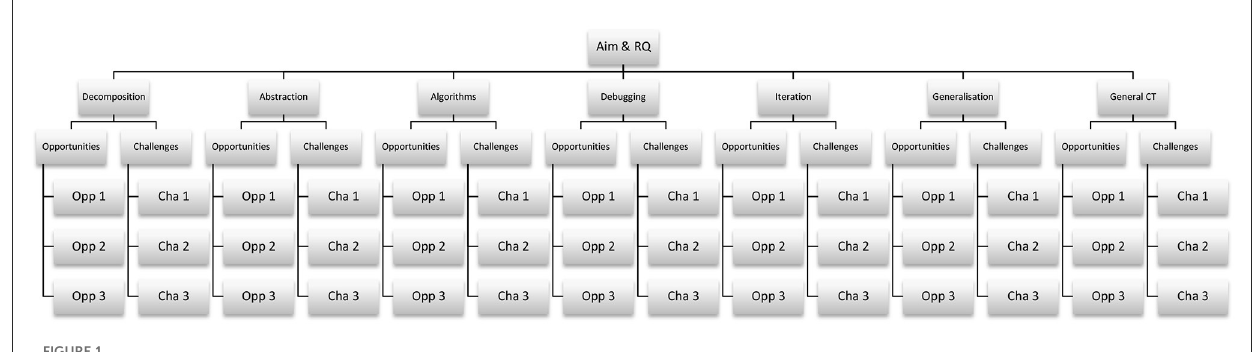
FIGURE1 Coding tree from directed content